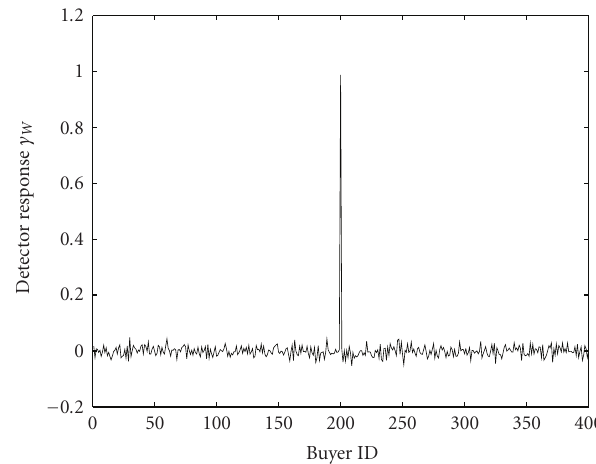
Figure 3: Identifying the “honest” buyer by the WCA. The WCA traces the traitor with the watermark W according to (4).